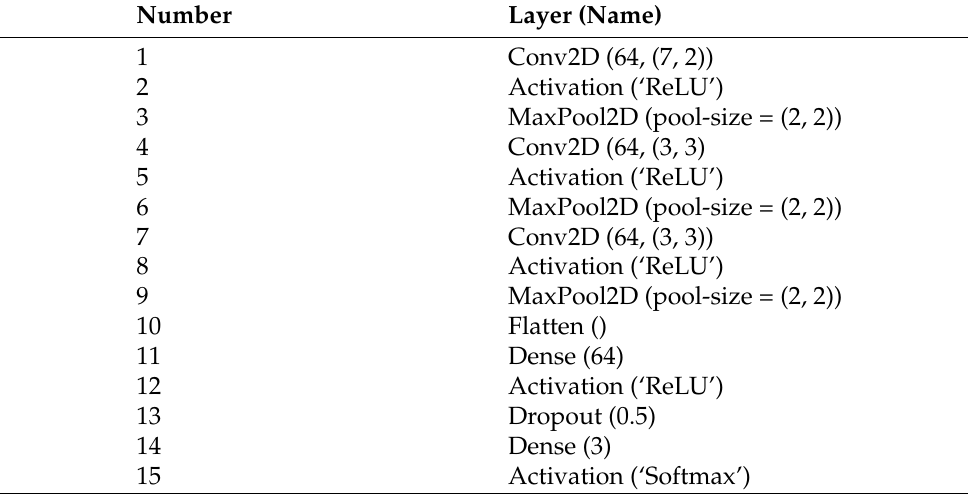
Table 1. 2DCNN model structure for